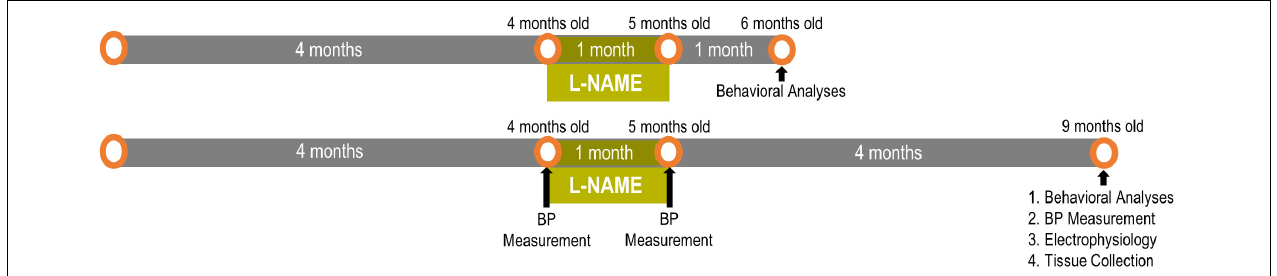
FIGURE 1 | Experimental timeline for L-NAME-induced transient hypertension: One cohort had 1 month of normotensive recovery and the other cohort had 4 months of recovery. Readouts were sequential with behavioral analyses preceding blood pressure and electrophysiological measurements.